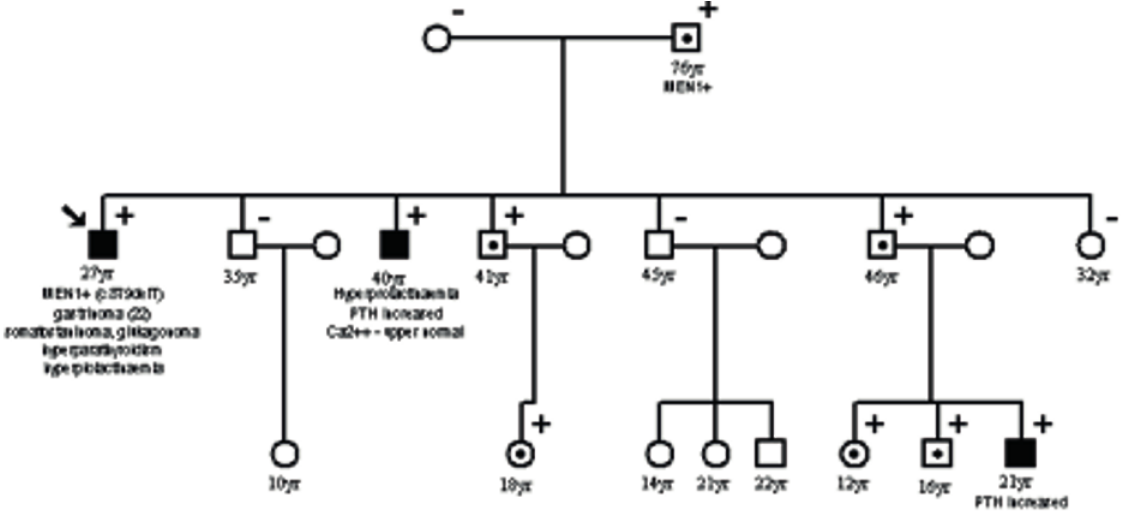
Figure 5. Pedigree of the family with MEN1 c.879delT mutation. Proband is represented by an arrow. Circles represent females, squares – males; „+“ and dots in the centre denotes confi rmed mutation carriers, „-“ tested negative patients; fi lled symbols represent affected patients; Age and brief phenotypic description is given near the